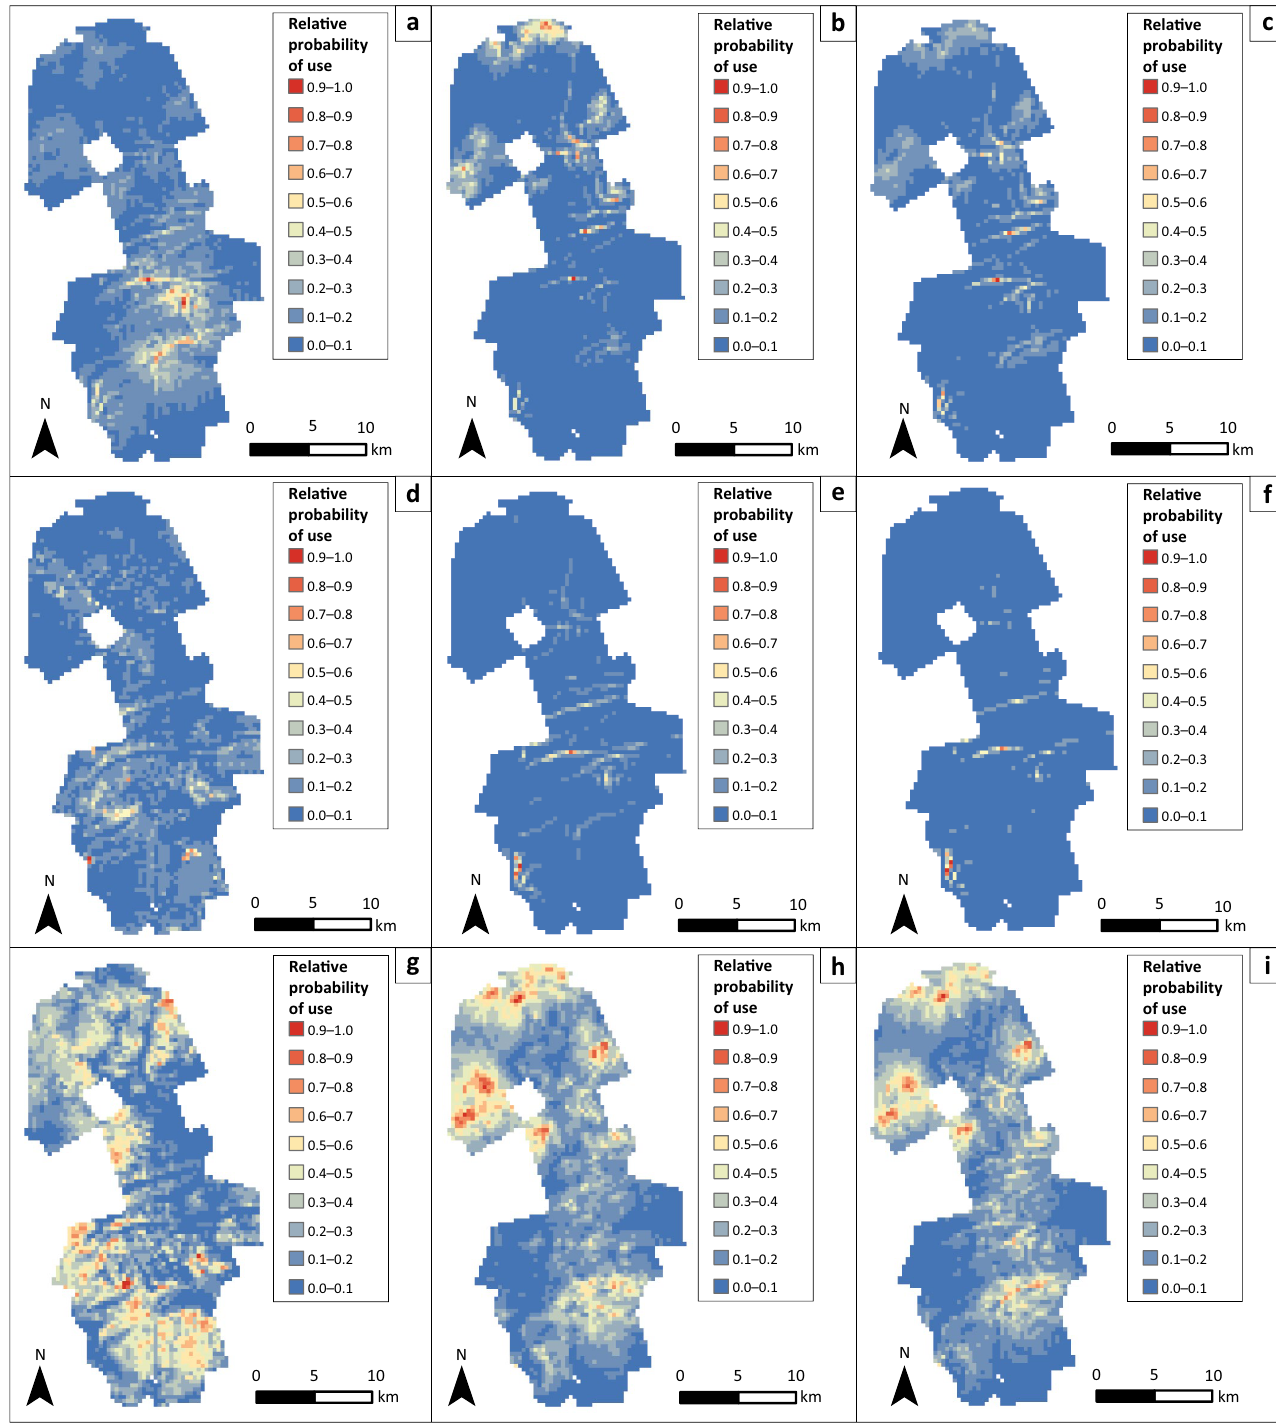
For an animation of predicted use across the entire study period, see Appendix 4. FIGURE 3: Predicted use by elephants in Addo Elephant National Park on three representative dates throughout the study period (rows) and for the three times of day considered (columns). (a) 01 January 2011, 06:00, (b) 01 January 2011, 12:00, (c) 01 January 2011, 16:00, (d) 23 April 2011, 06:00, (e) 23 April 2011, 12:00, (f) 23 April 2011, 16:00, (g) 30 September 2011, 06:00, (h) 30 September 2011, 12:00, (i) 30 September 2011,